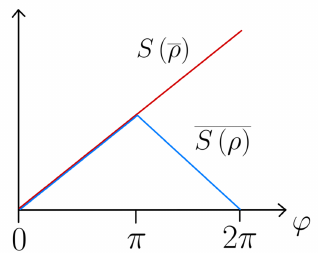
Figure 1 . In 1 + 1 dimensions, we consider a theory on a circle with periodicity 2 π . The graph is a schematic picture for the von Neumann entropy on the interval A = [0 , ϕ ] . The thermal result (in red) is calculated by first averaging the pure density matrix and then taking the von Neumann entropy. The pure ‘Page-like’ result can be obtained by averaging over the pure von Neumann entropies (in